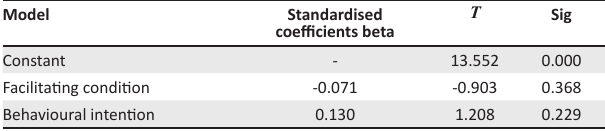
TABLE 4: Regression result of determinants of use of electronic information